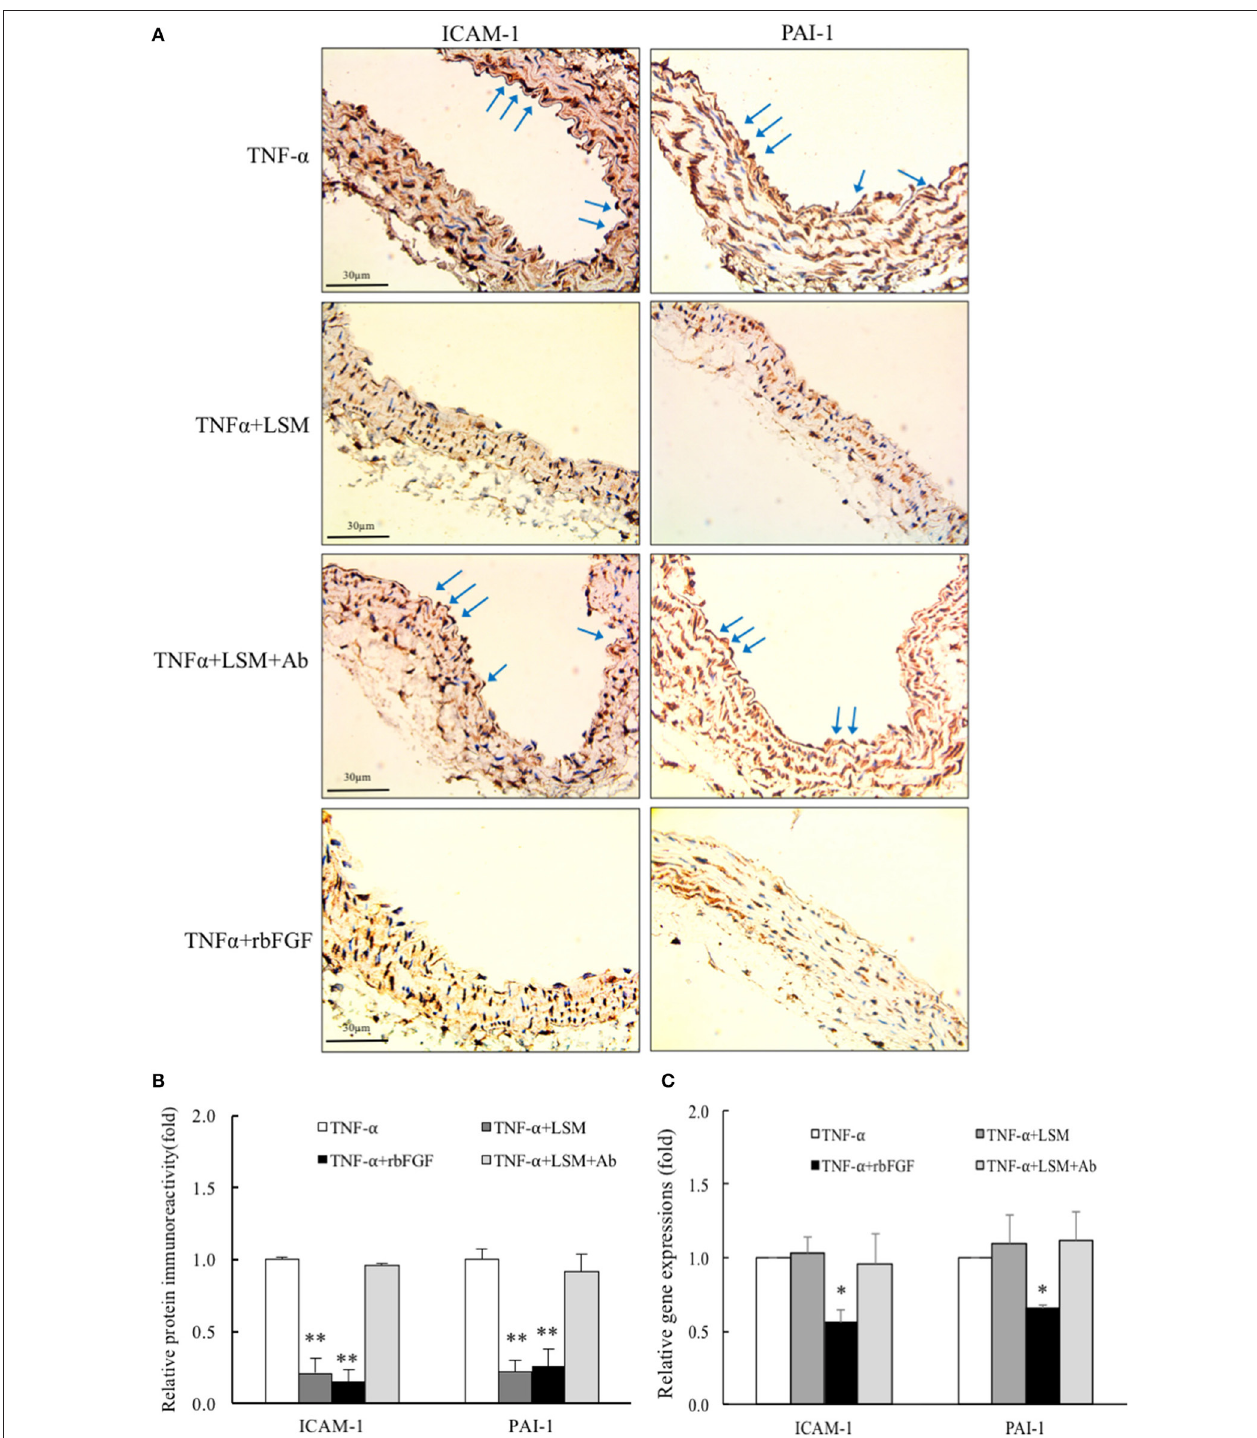
FIGURE 7 | LSM and rbFGF suppresses TNF- α -induced ICAM-1 and PAI-1 protein and gene expression in vivo. (A) Immunohistochemical staining of ICAM-1 and PAI-1 proteins in thoracic aorta tissue. Representative images showing immunoreactivities of ICAM-1 and PAI-1 in the aortic endothelial layers (brown color as arrow) were decreased in the TNF- α + LSM and TNF- α + rbFGF groups compared to in the TNF- α group. The immunoreactivities of ICAM-1 and PAI-1 in the aortic endothelial layer were not decreased in the TNF- α + LSM + Ab group compared to in the TNF- α group ( n = 3). (B) Immunoreactivity signals in endothelial layers from 4 groups was quantified for all immunohistochemical images. ** p < 0.01 indicates a significant difference relative to the TNF- α group. (C) At 24h after TNF- α i.p. injection, ICAM-1 and PAI-1 gene expressions were reduced by approximately to 0.55- and 0.64-fold in lung tissues in the TNF- α + rbFGF groups compared to in the TNF- α group. Data are expressed as the mean ± S.E.M. ( n = 3). * p < 0.05 indicates a significant difference relative to the TNF- α